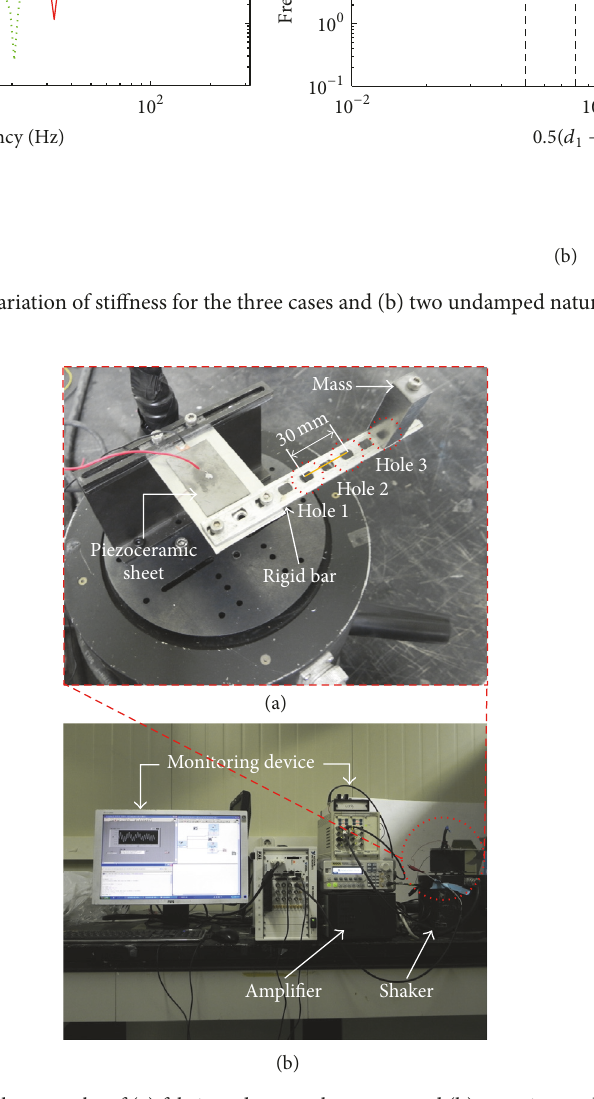
Figure 3: Photographs of (a) fabricated energy harvester and (b) experimental